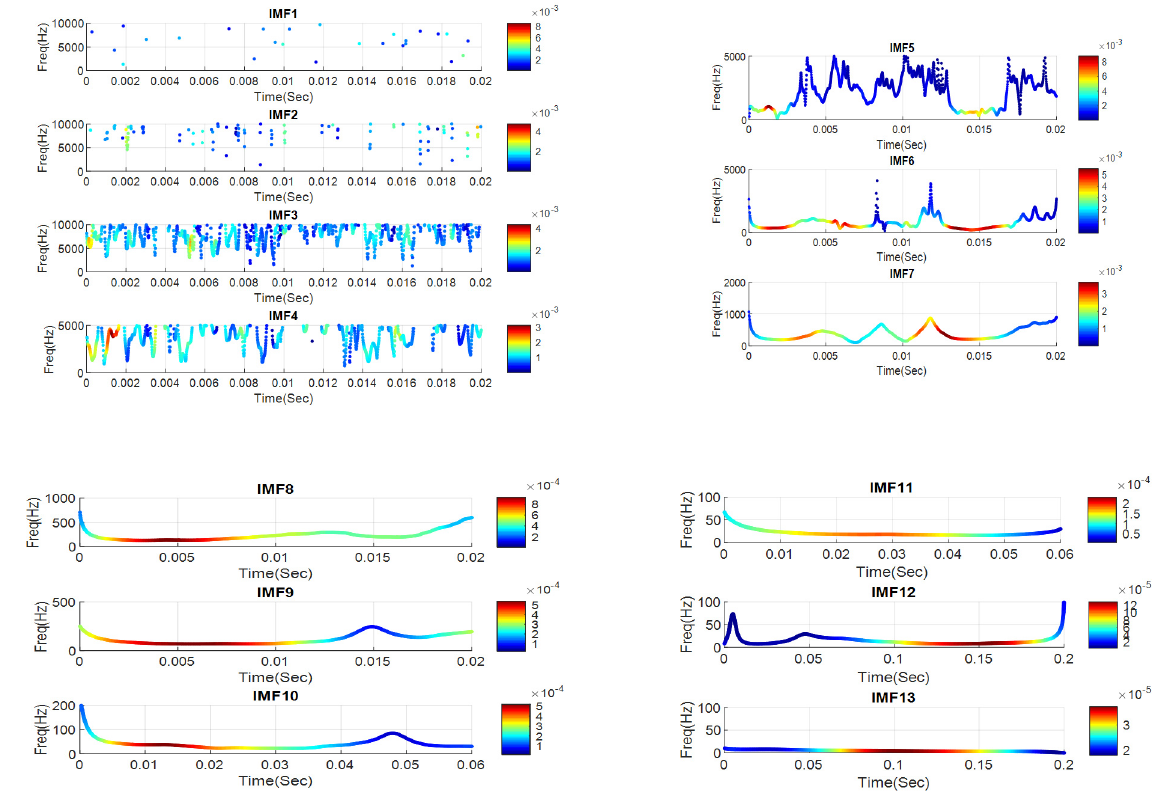
Figure 13. Instantaneous frequencies of A90C1 Serviceable Pole 1 generated by original HHT.